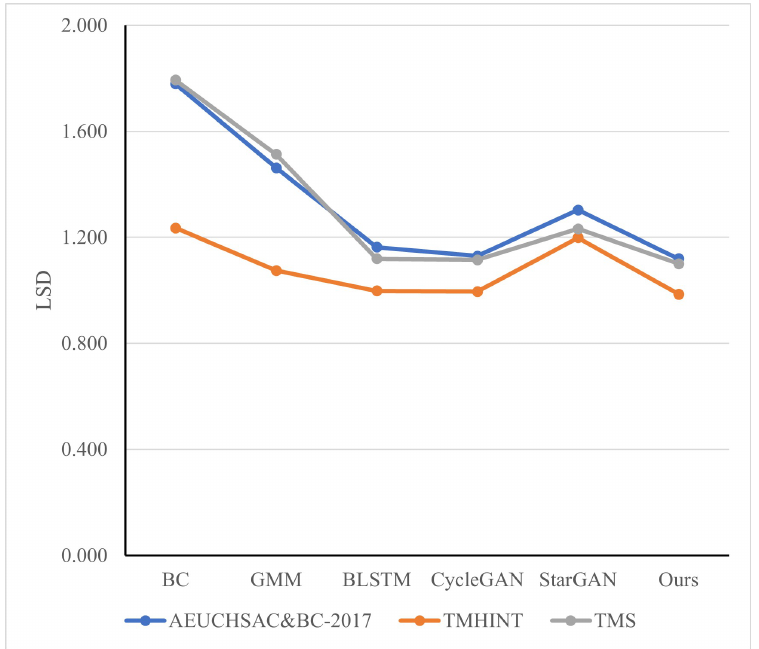
Figure 10. LSD scores of enhanced BC speech obtained by different